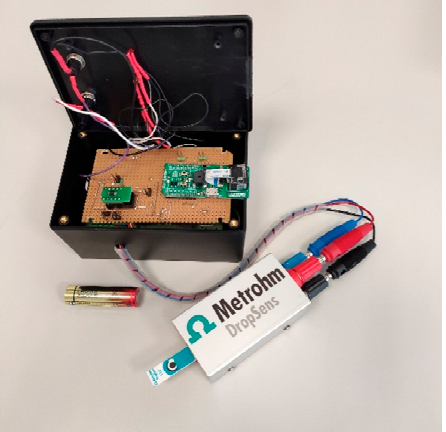
Figure 2. The smart portable wireless potentiostat.